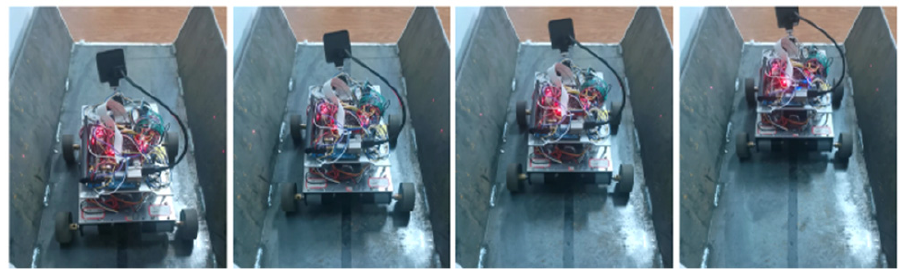
Figure 13. Experiment of the robot tracking the lane’s centerline.